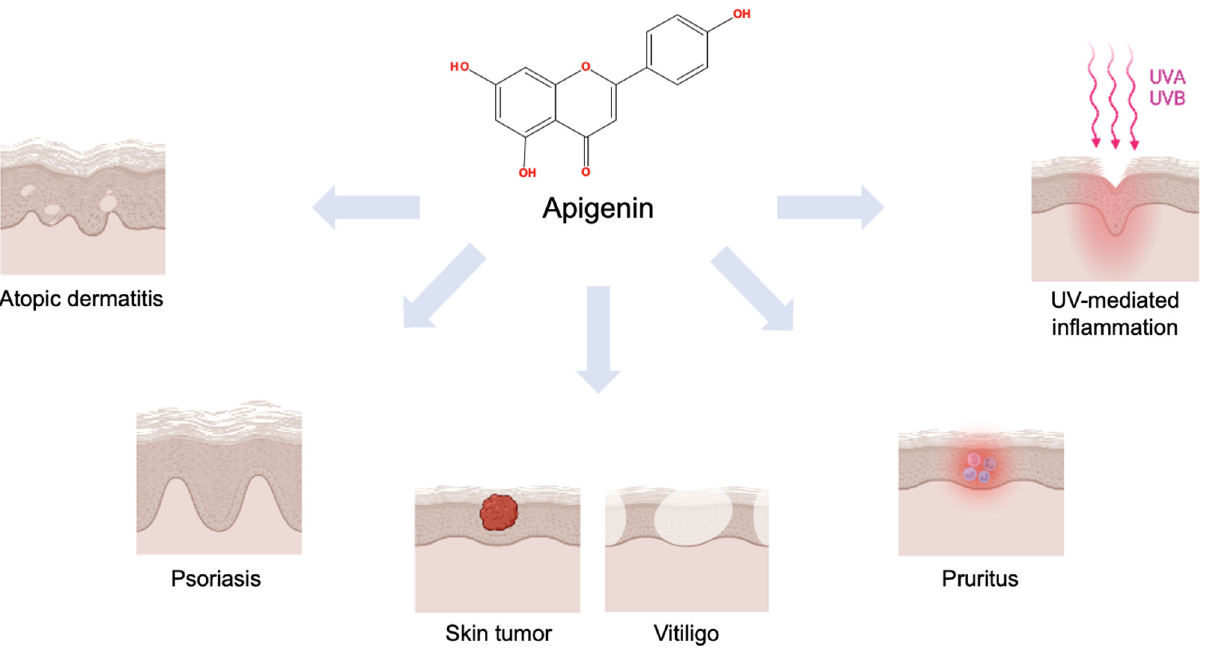
Figure 2. Scheme of the therapeutic efficacies of apigenin on the skin. This figure was created with BioRender.com.